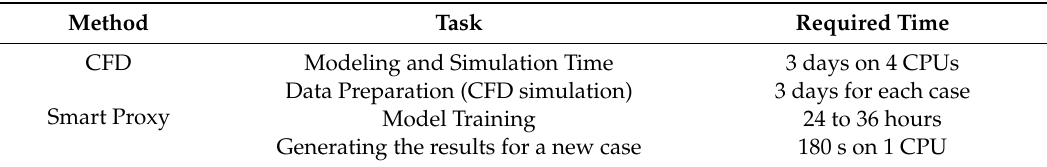
Table 5. Comparison between speed of run for CFD and smart